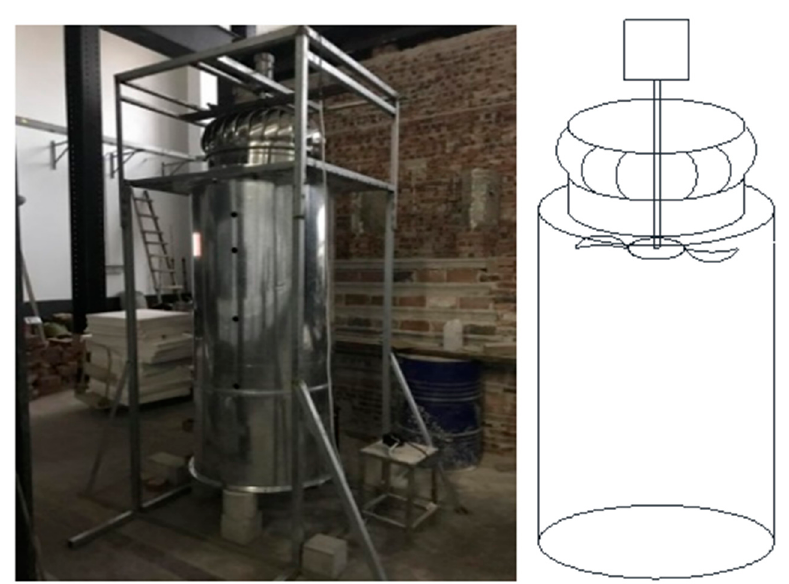
Figure 7. Performance optimization platform of a QM-600 swirl natural